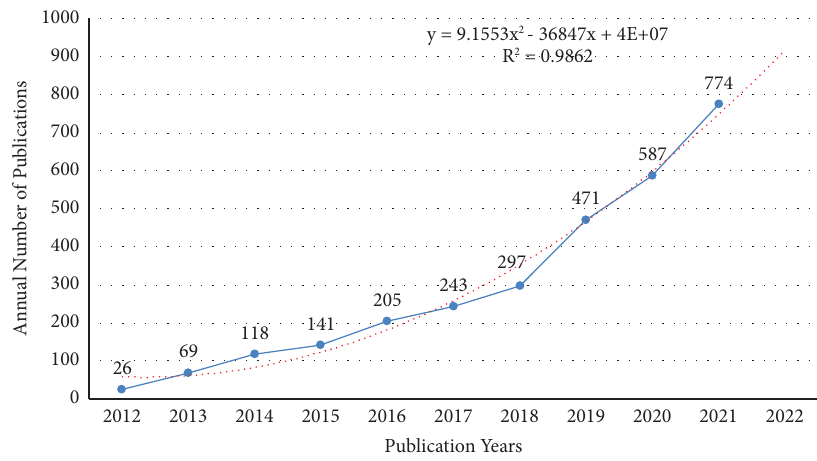
Figure 2: Annual papers output and ftting curve of publications in